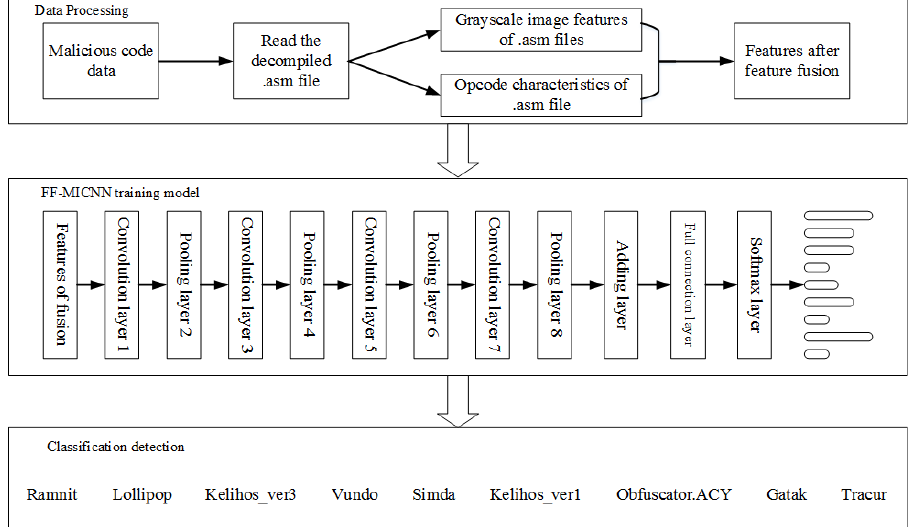
Figure 1. Malicious code detection method based on FF-MICNN.